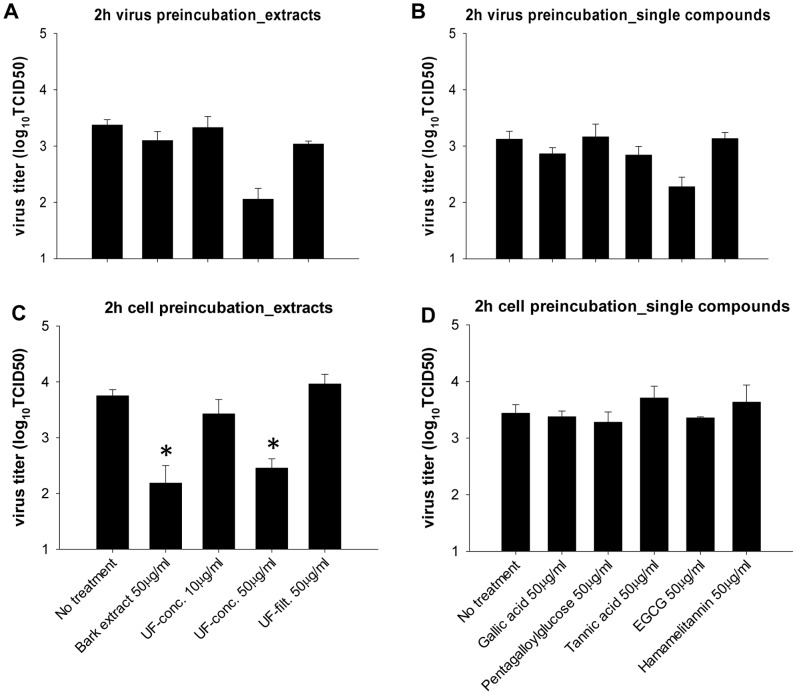
Effect of virus or cell preincubation with Hamamelis extracts or individual compounds.(A–B) Preincubation of pandemic H1N1 A/Lux/46/2009 for 2 h with virus growth medium (“no treatment”) or bark extract/UF-fractions (A) or individual compounds (B) before infection of A549 cells (MOI 0.1) and titration 24 h post infection (p.i.). (C–D) Preincubation of A549 cells for 2 h with virus growth medium (“no treatment”) or bark extract/UF-fractions (C) or single compounds (D) before three washes with PBS, infection with pandemic H1N1 (MOI 0.1) and titration 24 h p.i. All experiments were done in at least triplicates. * significant difference (p<0.05) as compared to “No treatment”.